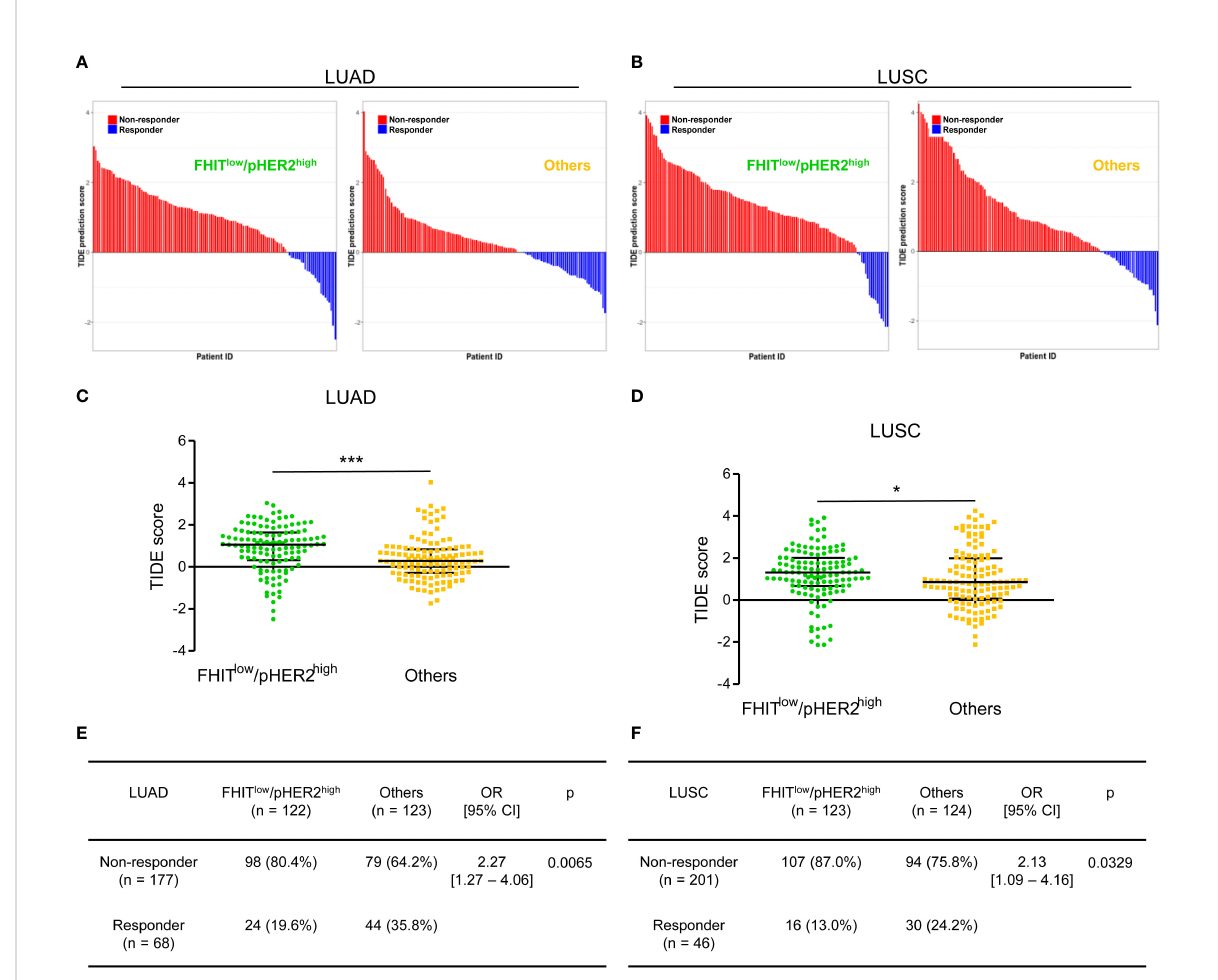
FIGURE 5 The FHIT low /pHER2 high signature predicts a poor response to immune checkpoint inhibitors in Firehose Legacy TCGA-LUAD and TCGA-LUSC cohorts. (A, B) Waterfall plots of TIDE (Tumor Immune Dysfunction and Exclusion) prediction score across all LUAD (A) and LUSC (B) tumors. Tumors were separated according to their FHIT/pHER2 status. Blue indicates a tumor that is predicted to respond to therapy. Red indicates a non-responder. In each category, tumors were sorted in descending order according to their TIDE prediction score. (C, D) Comparison of TIDE prediction scores by Mann-Whitney test between FHIT low /pHER2 high tumors and others in LUAD (C) and LUSC (D) cohorts. *p < 0.05; ***p < 0.001. (E, F) Contingency table and Fisher ’ s exact p-value to estimate the signi fi cance of the association between FHIT/pHER2 status and response to immunotherapies in LUAD (E) and LUSC (F)